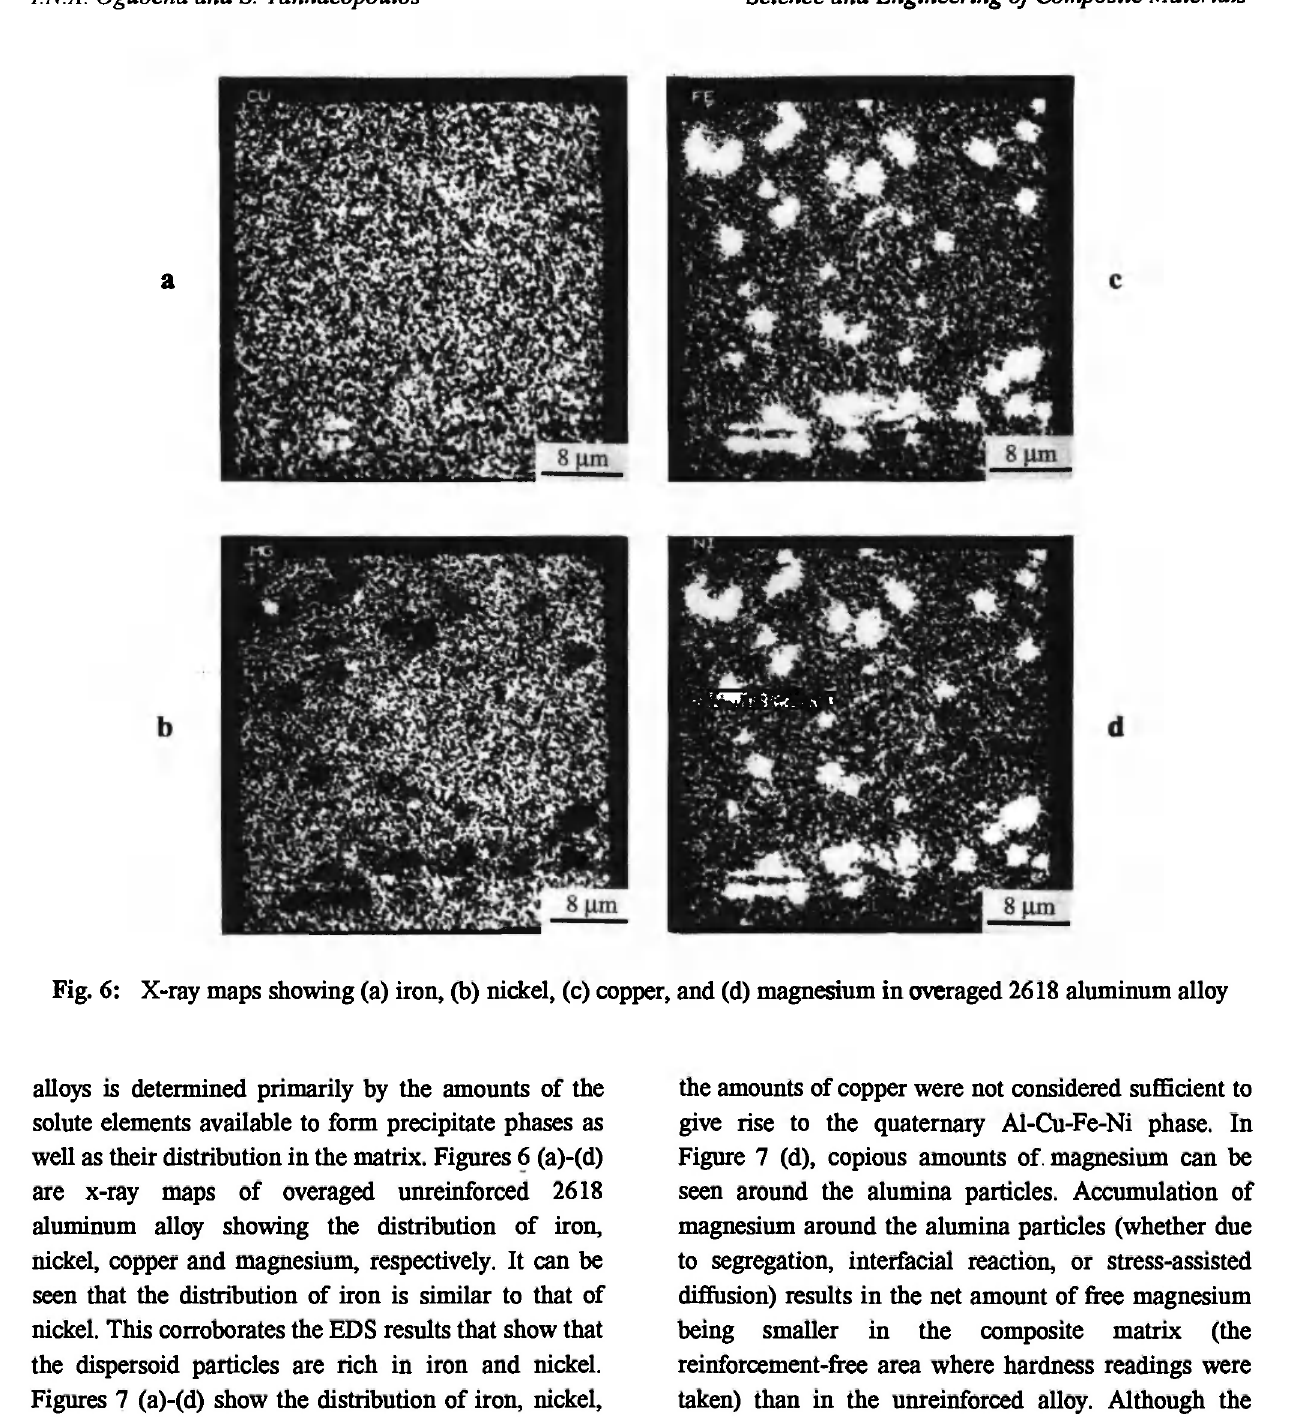
Fig. 6: X-ray maps showing (a) iron, (b) nickel, (c) copper, and (d) magnesium in averaged 2618 aluminum alloy